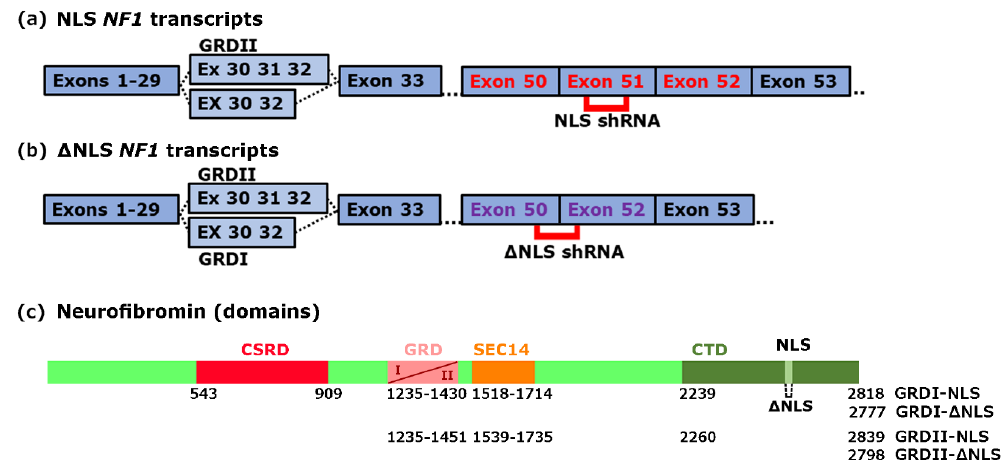
Scheme 1. Schematic representation of NF1 transcripts and neurofibromin domains. ( a ) and ( b ) depict alternative spliced events in the NF1 gene that produce NLS and ∆ NLS transcripts and